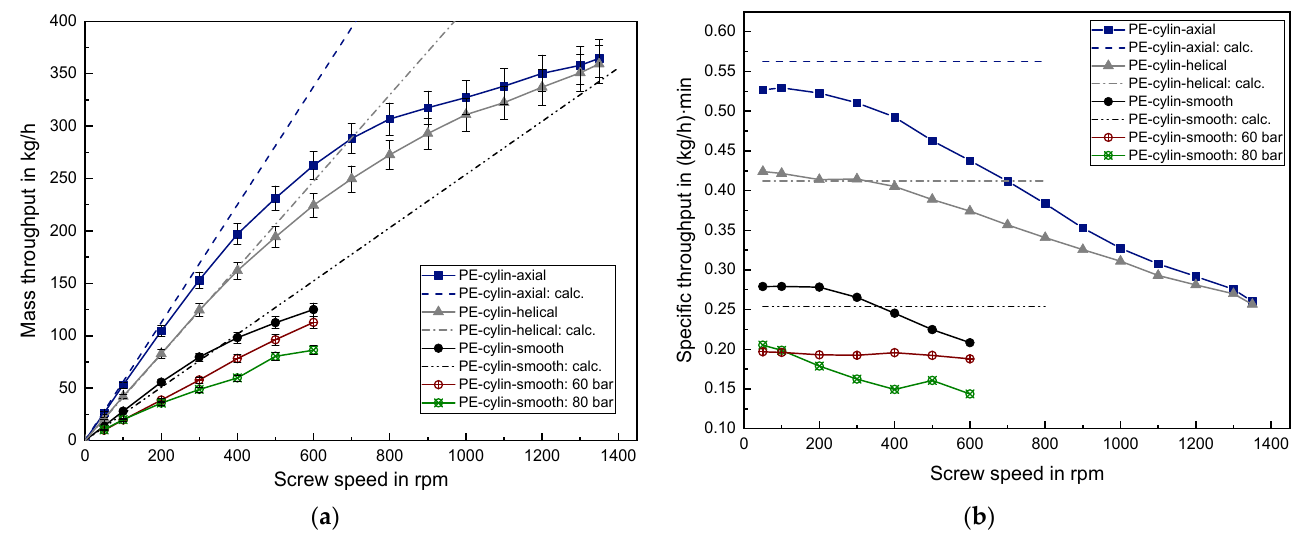
Figure 7. ( a ) Absolute mass throughput and ( b ) specific mass throughput for cylindrical PE. Comparing the calculated throughput with the measured throughput of cylindrical